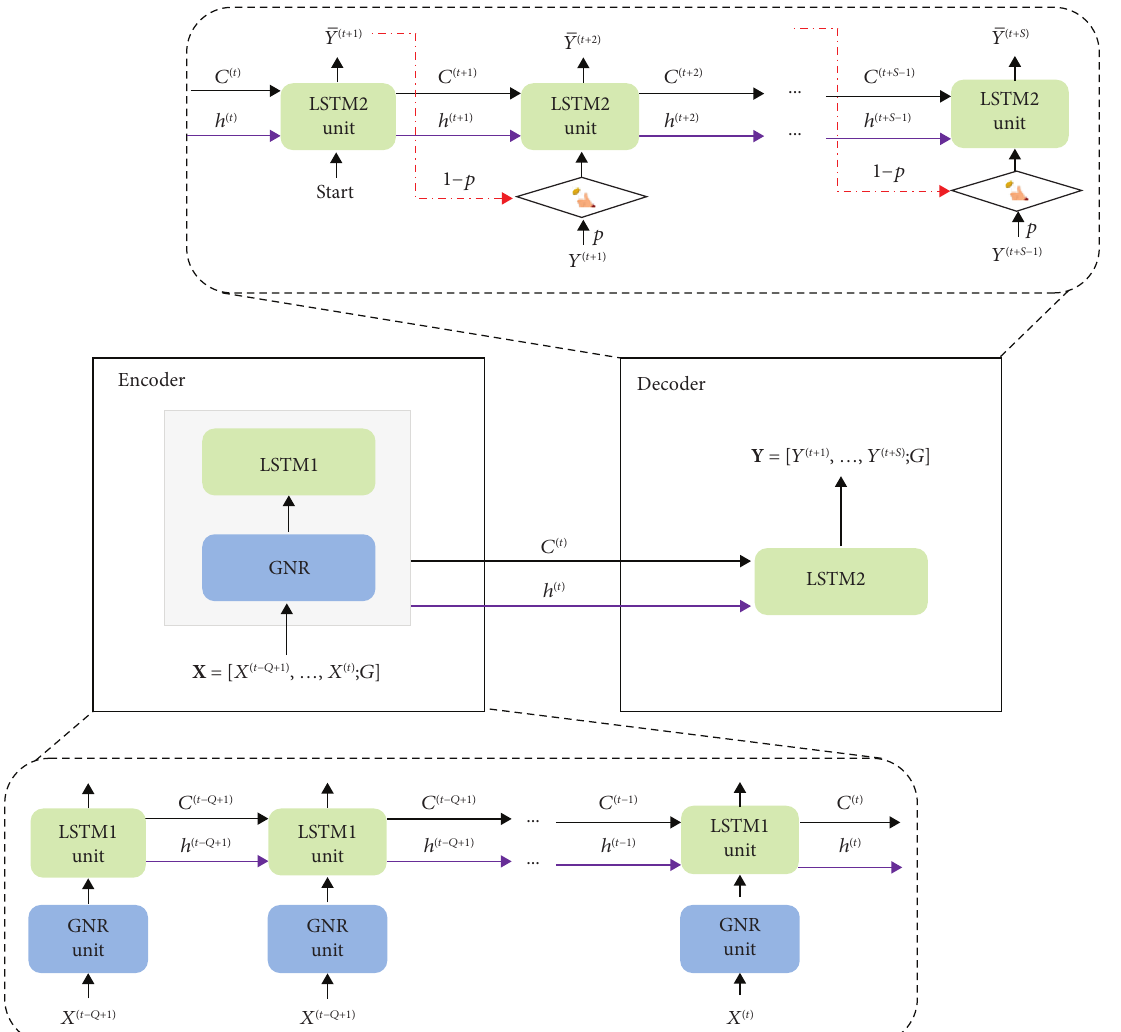
Figure 4: Network structure of the SS-LSTM prediction